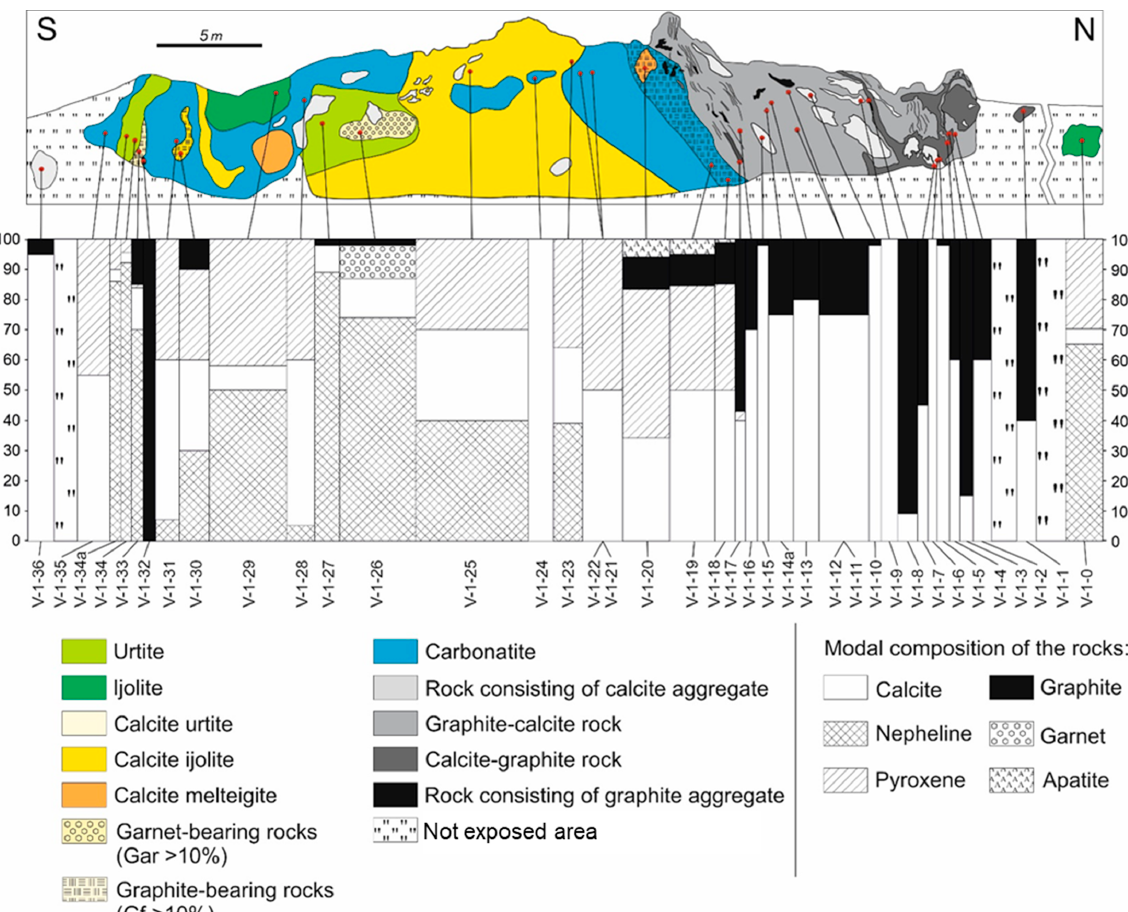
Figure 3. Geological scheme along section V-1 in Figure 2 with modal compositions of respective sampling points.